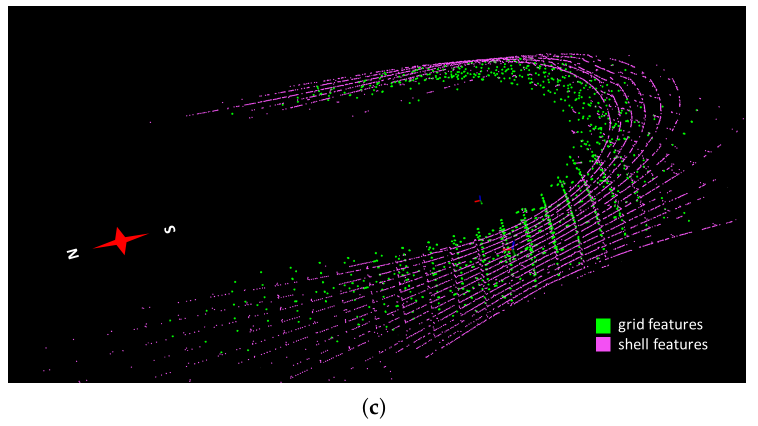
Figure 5. Example of extracting grid features and shell features. ( a ) shows a GNSS-denied environ- ment with space grid structures, where we operated a UAV with a lidar navigation system flown in. The photo was taken facing north. ( b ) shows the real-time point cloud collected by the lidar, where the color of the point represents the reflection intensity. ( c ) shows the grid features and shell features extracted from the point cloud; the grid features are painted in green and the shell features are painted in